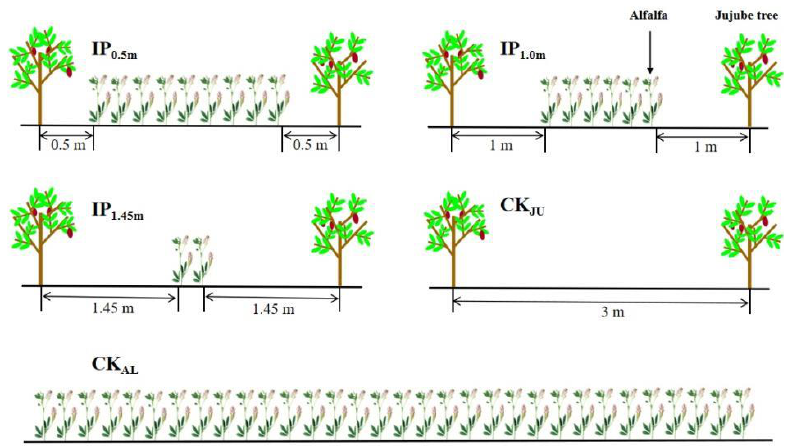
Figure 1. Intercropping patterns with different distances.